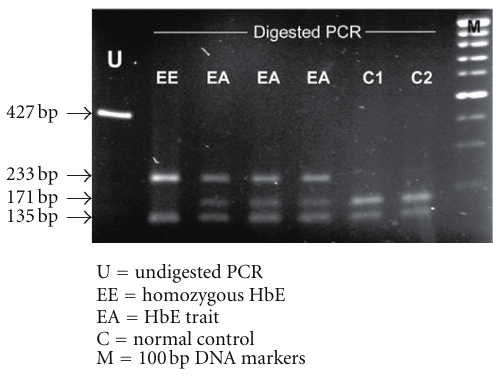
Figure 1: Molecular analysis of HbE mutation using PCR-RFLP by Mnl I